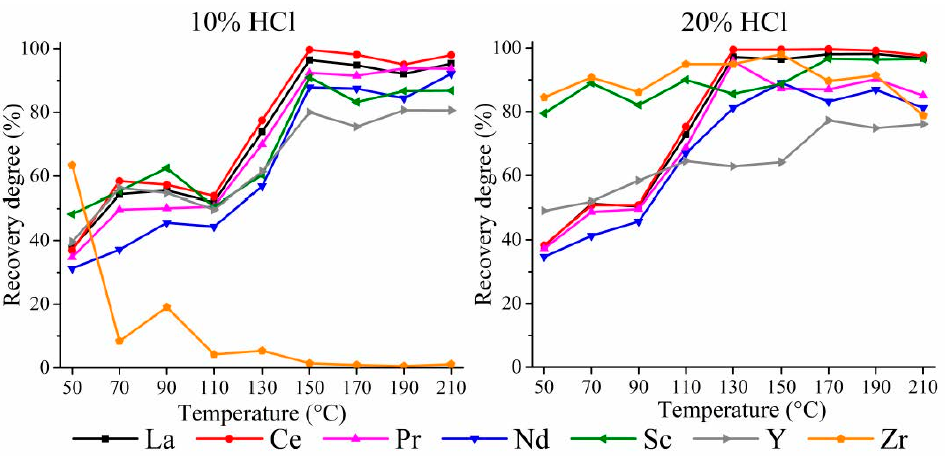
Figure 3. The effect of the temperature on recovery degree of the minor elements for the leaching of the WAT sample using 10% and 20% HCl at S:L ratio = 1:11 for 60 min.